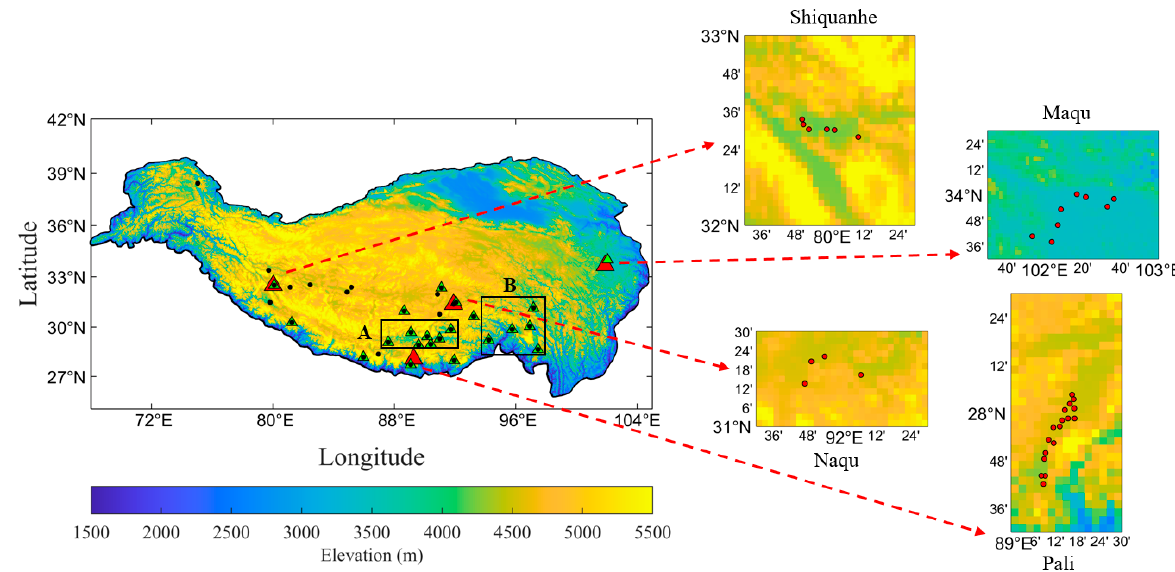
Figure 1. Distribution of the in situ SM observation stations. Red triangles refer to the SM measure- ment networks. The black dots are the TIPEX-III SM measurement stations. The green triangles are the weather stations that overlap with the TIPEX-III SM measurement stations. The black boxes represent the stations in the south-central TP (region A) and southeast TP (region B).